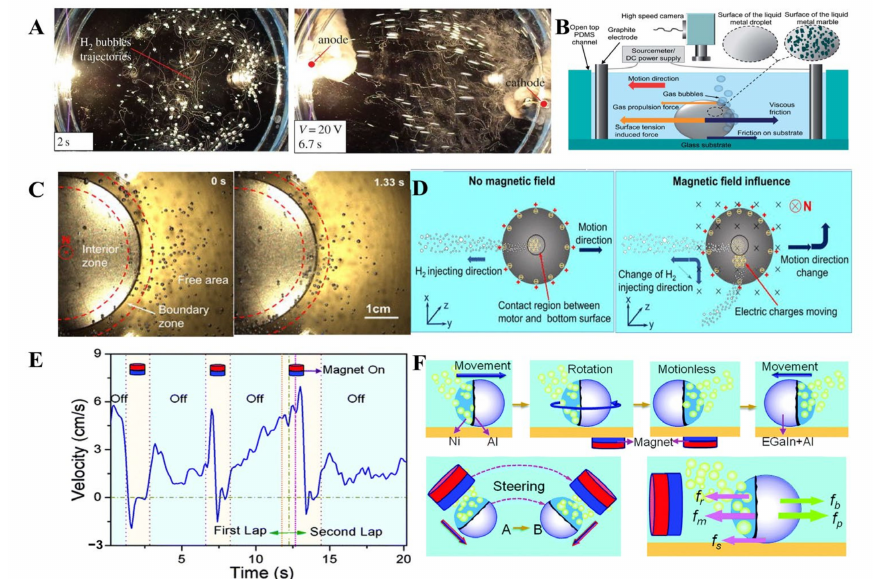
Figure 16. Hybrid-driven MLMTs. ( A ) Sequential snapshots of the GaIn 10 -Al motors under before ( left ) and after ( right ) applying an electric field [85]. ( B ) A schematic illustration of the forces influencing the motion of a MLMTs with or without nanoparticle coating [102]. ( C ) Continuous captures of a mass of MLMTs’ motion under magnetic field. ( D ) The schematic of electrical charge alteration is affected by the external magnetic field [86]. ( E ) The on-off motion control of the MLMTs. ( F ) The schematic of rotation and alteration of the MLMTs by a magnet